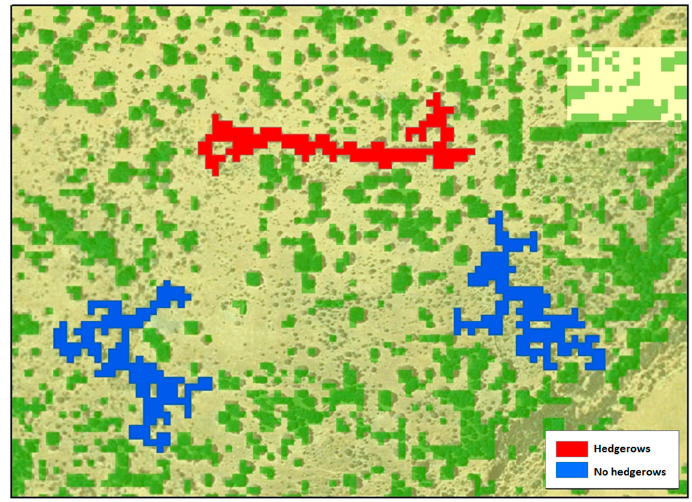
Figure 5. Result of hedgerows identification. Areas represented in red are identified as hedgerows, while blue areas are discarded. while blue areas are discarded.